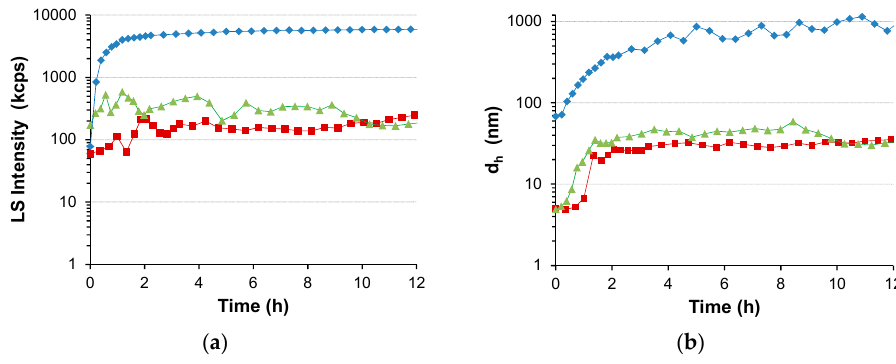
Figure 2. Representative DLS data of S-PDMAEMA 60 particles prepared at pH 8.0 (blue diamonds ♦ ), pH 7.4 (green triangles ▲ ) and pH 6.9 (red squares ■ ) using a 1:1 feed ratio of SS/PDMAEMA, corresponding to a 10 mM concentration of DMAEMA repeating units, a 1.57 g/L polymer concentration: ( a ) The total intensity of scattered light and ( b ) Mean hydrodynamic diameter of corresponding size distributions ( d h ) are shown, as observed over 12 h following acid-triggered initiation of particle growth. Data obtained at a 173° scattering angle using the Zetasizer instrument.